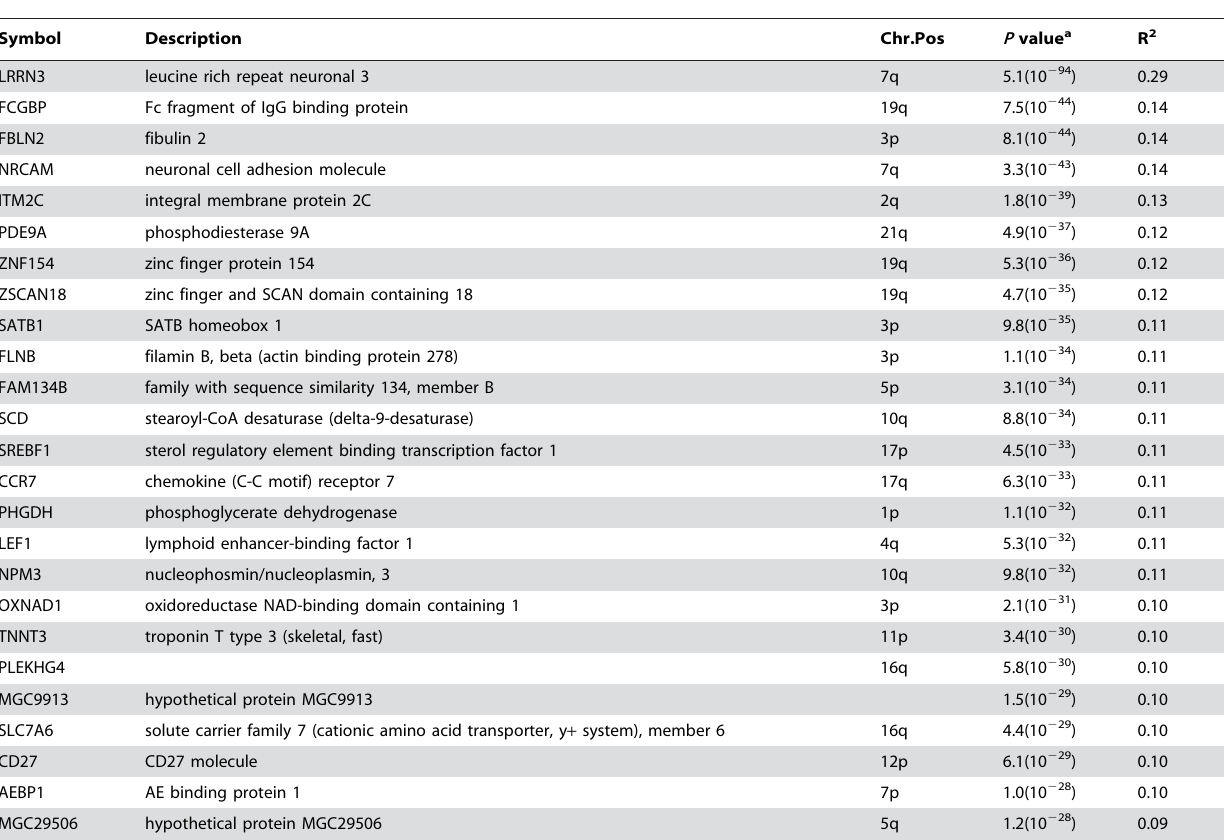
Table 5. Genes whose expression decreases with age in human lymphocytes.